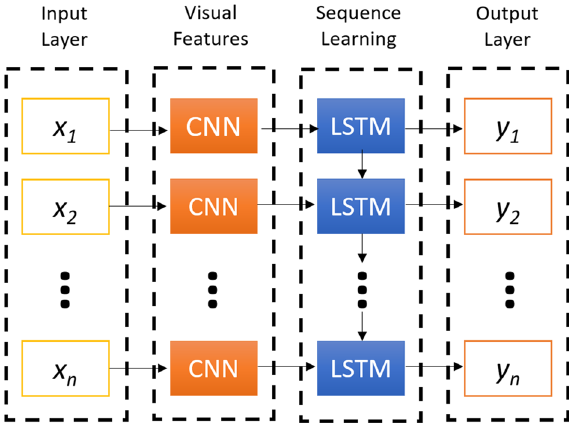
Figure 2. The basic architecture of the CNN-LSTM